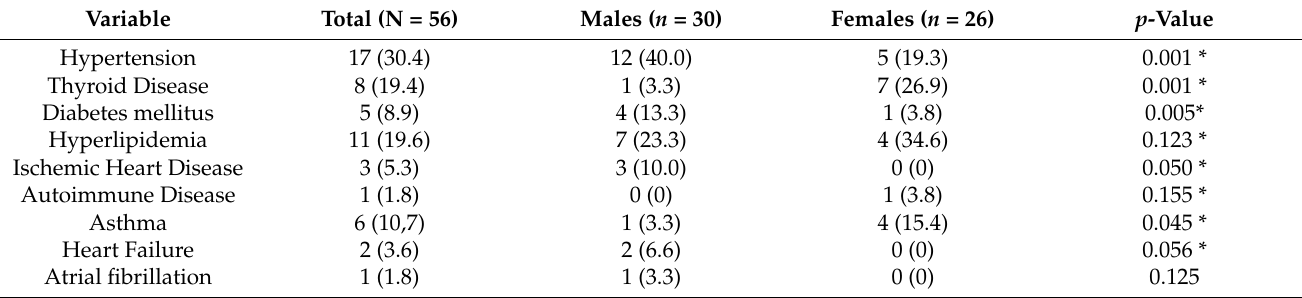
Table 4. Percentage of comorbidities (%) in Domokos’ population (N =